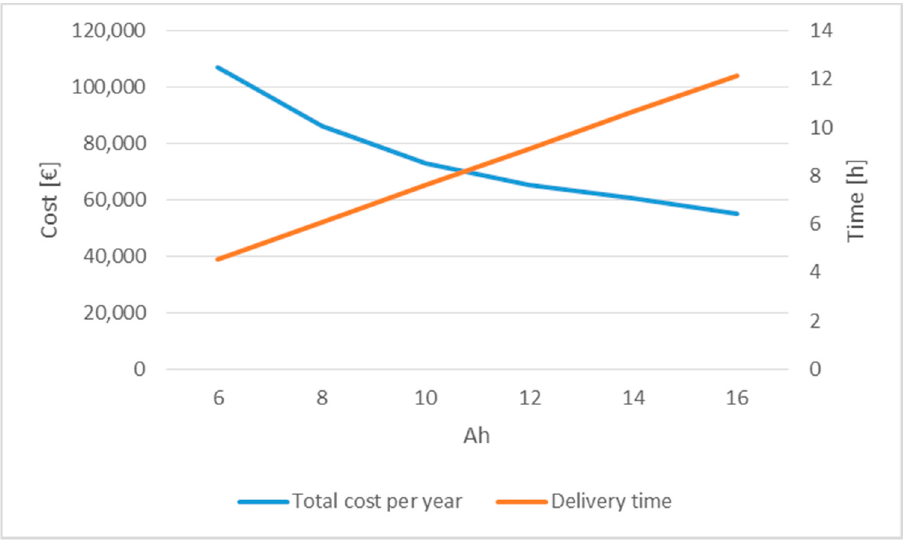
Figure 5. Objective functions.